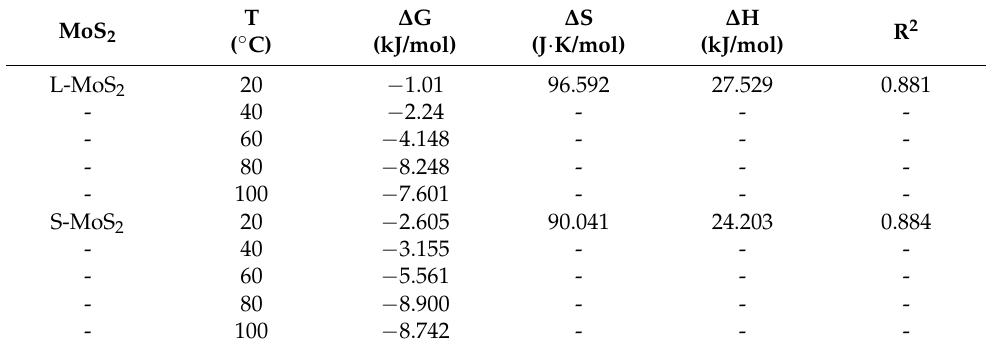
Table 3. Related parameters of adsorption thermodynamic model at different temperatures. MoS 2